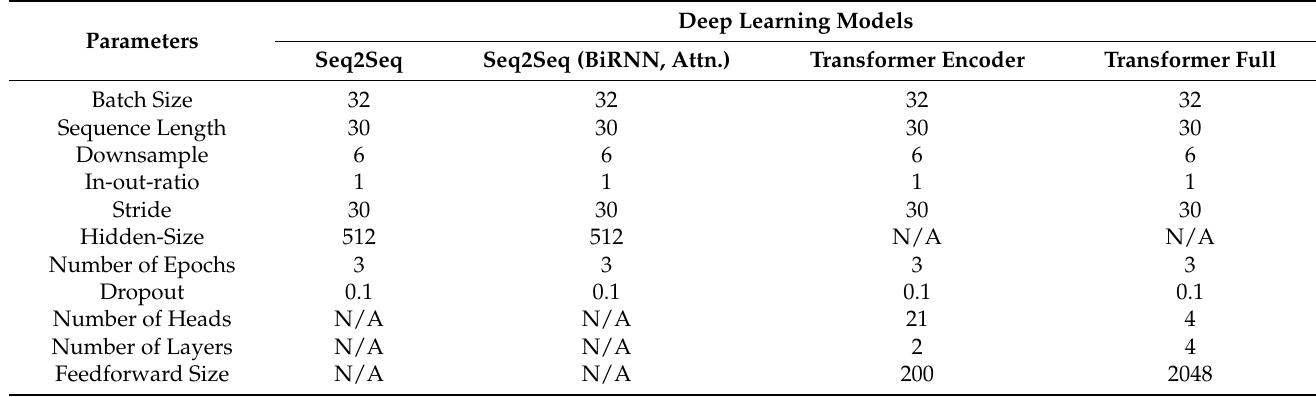
Table 2. Important training parameters used in different deep learning models. In addition to these parameters, both the Transformer models used tuning parameters β 1 = 0.95 and β 2 =